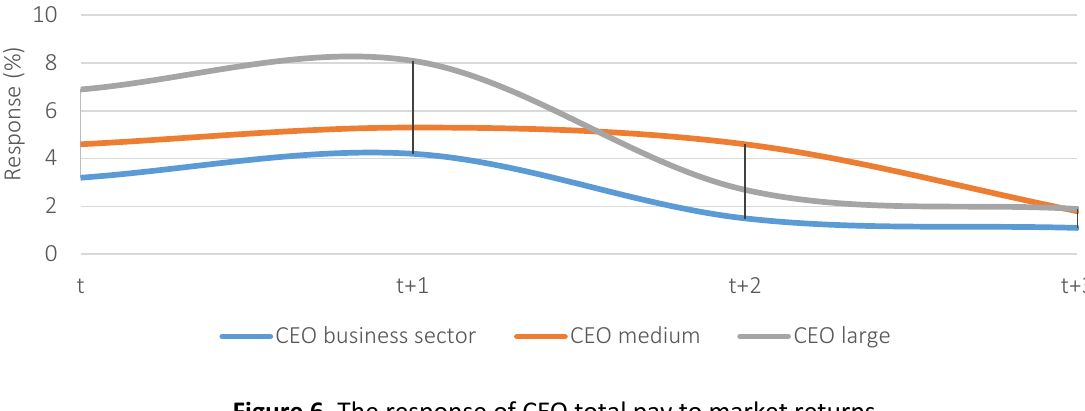
Figure 6. The response of CEO total pay to market returns